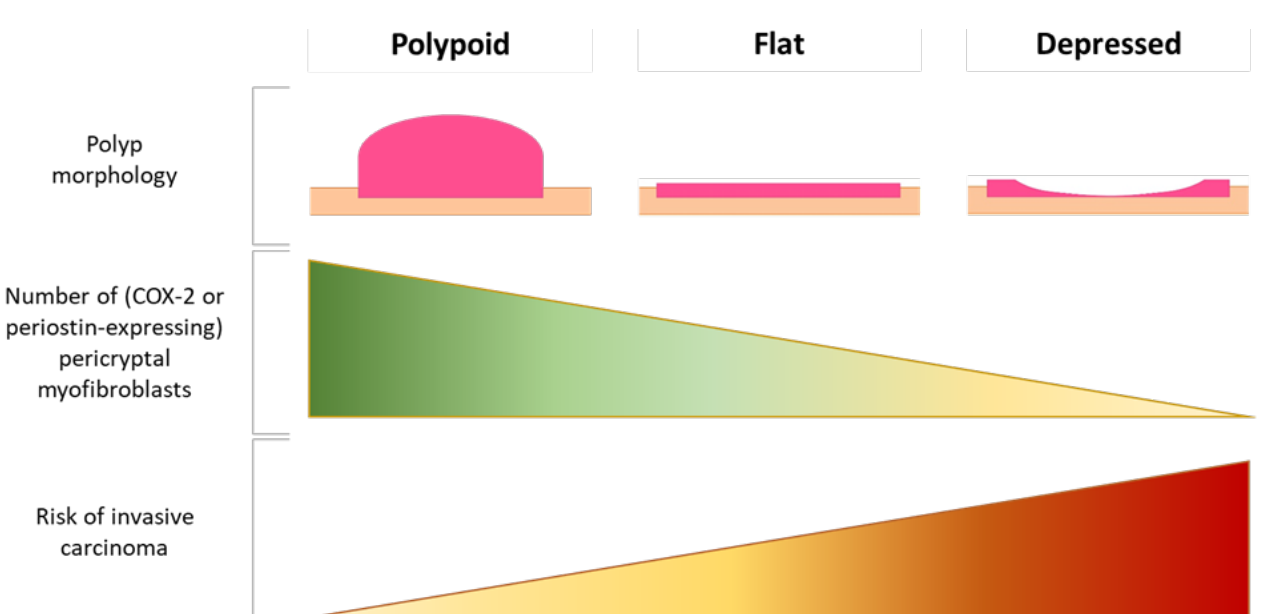
Figure 3. Relation between polyp morphology, pericryptal myofibroblasts, and risk of invasive cancer. (Created with BioRender.com).